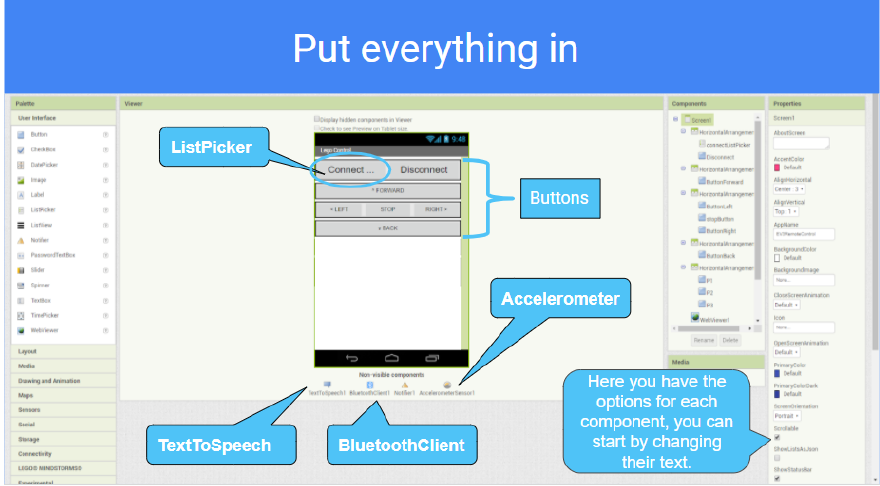
Figure 16. Example of tutorial given to the high-school students to learn how to design a User